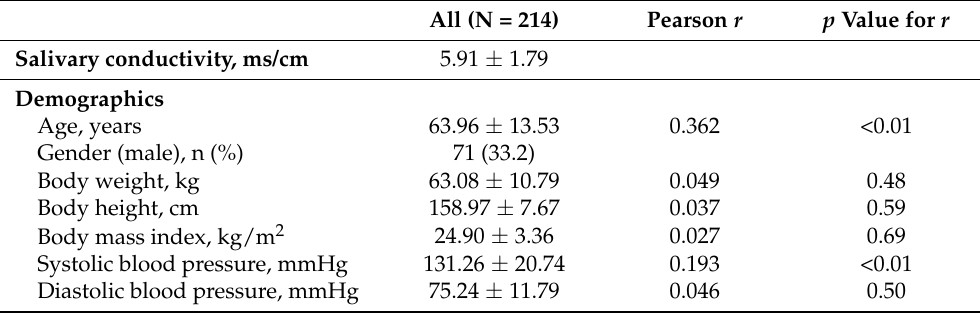
Table 1. Characteristics of the study population and the correlation between salivary conductivity and continuous variables.